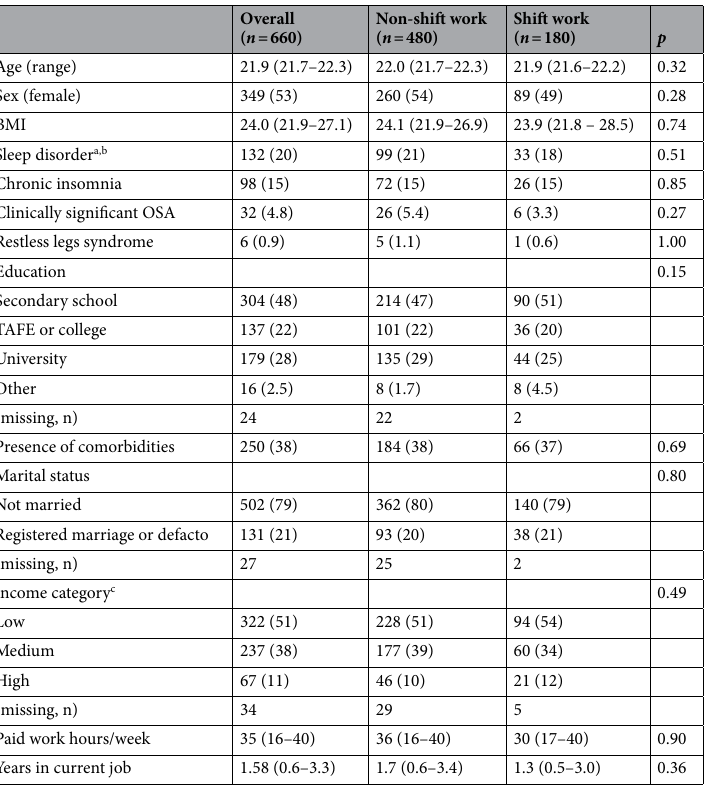
Table 1. Demographic characteristics of participants overall, and by shift work status. Data are median (IQR) or n (%) unless otherwise specified. Differences between shift work groups were determined using Pearson’s chi-squared test, Wilcoxon rank sum test, or Fisher’s exact test. a Sleep disorder columns will not add to totals, as participants could meet criteria for more than one common clinically significant sleep disorder. b Sleep disorders are expressed as n(%). c Income categories in $AUD after tax include low (< $32,000 per annum), medium ($32,000—$64,999 per annum), and high (≥